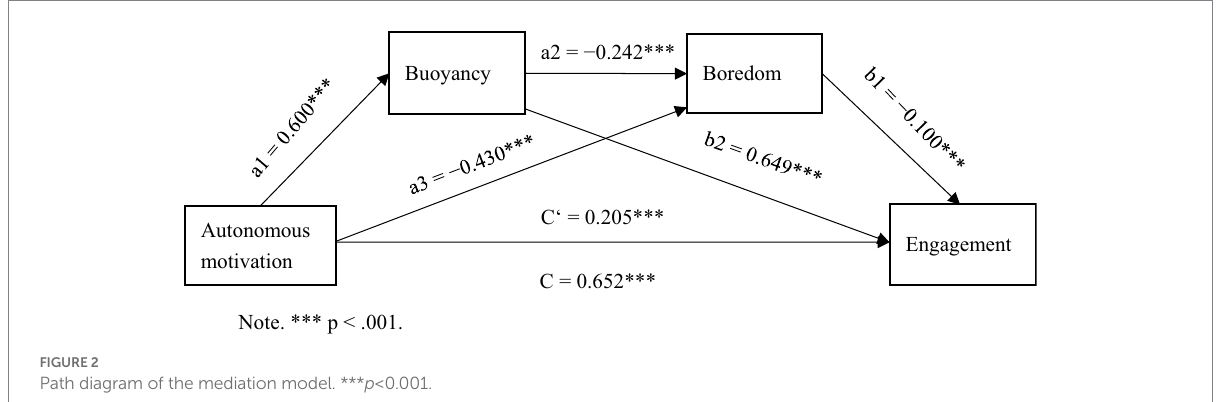
FIGURE 2 Path diagram of the mediation model. *** p < 0.001.